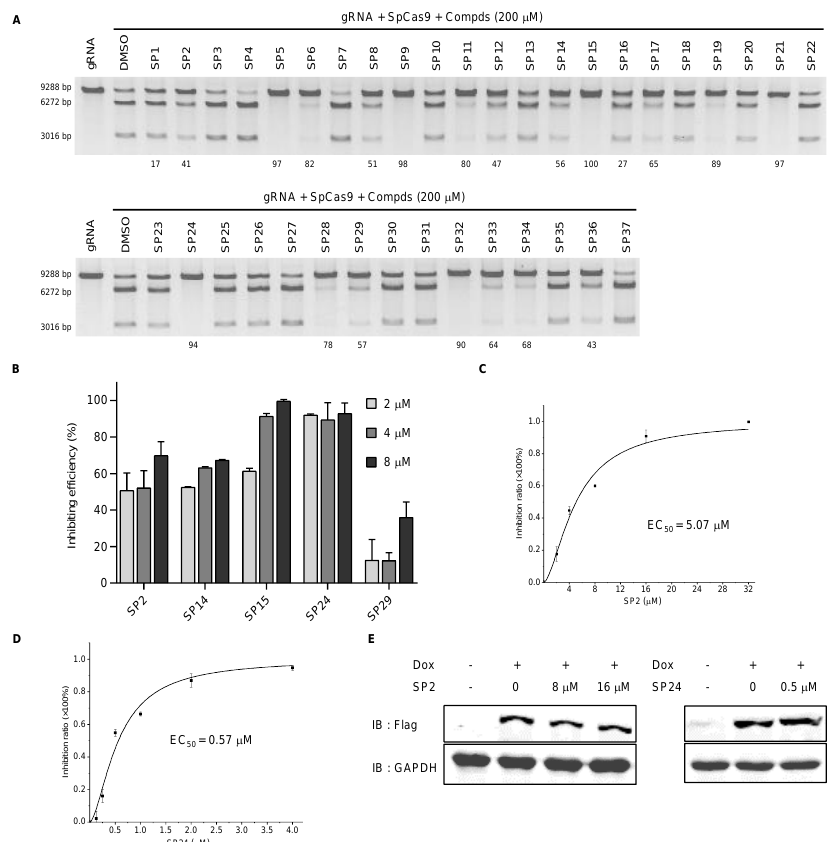
Figure 3. Analysis of in vitro and in cellulo activities of SP series compounds. ( A , B ) The SP series compounds were examined in vitro DNA cleavage assays ( A ) and reporter cells ( B ) as above. The number indicates the compound’s inhibition rate. ( C , D ) Reporter cells were cultured in Dox (2 μ g/mL) plus DMSO or SP2/SP24 at the indicated concentrations for 72 h before flow cytometry analysis. SP2 and SP24 EC 50 were calculated to be 5.07 μ M ( C ) and 0.57 μ M ( D ), respectively. Error bars represent SD from three biological repeats. ( E ) Flag-tagged SpCas9 protein expression was determined by western blotting with GAPDH serving as the loading control.